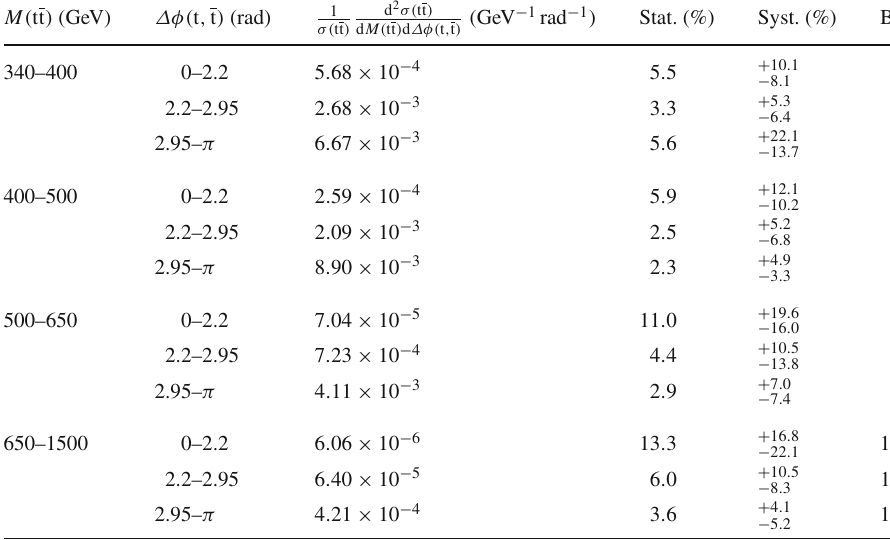
normalized tt double-differential cross sections in different bins of M ( tt ) and Δφ( t , t ) , along with their relative statistical and systematic